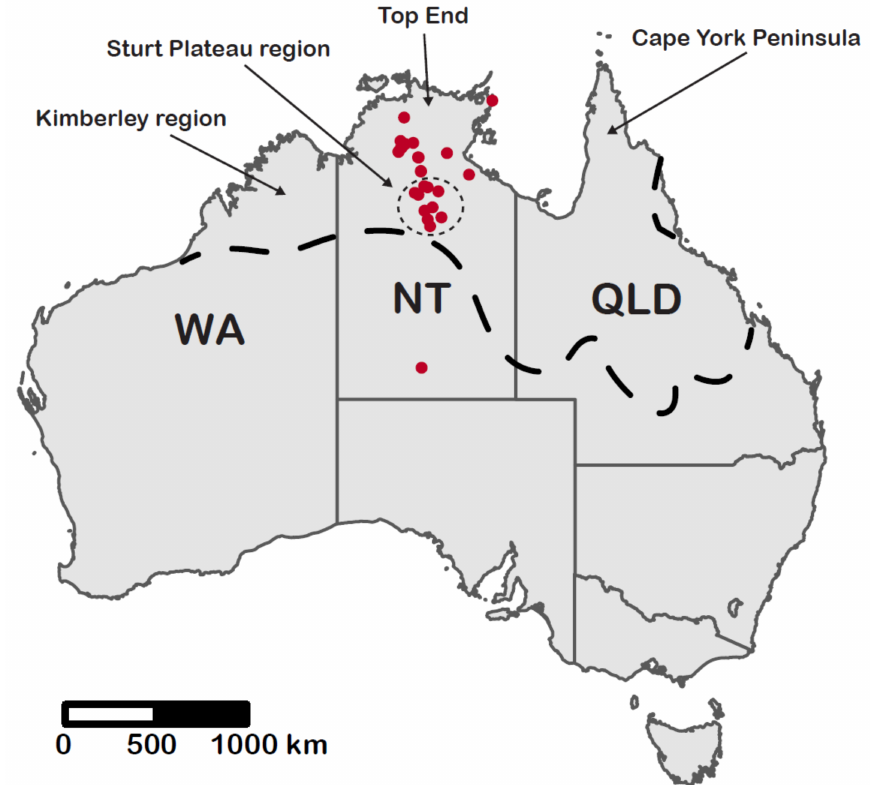
Figure 6. Map of Australia showing collection localities (red dots) for sequenced specimens of the Tetramorium spininode group. Many localities represent multiple sites. The four major biogeographic regions in northern Australia are indicated. The dashed line represents the approximate southern boundary of the monsoonal zone, where rainfall is very heavily concentrated in a summer wet season. Total annual rainfall ranges from about 2000 mm on the Tiwi Islands in the Top End to 500 mm on the southern boundary with the central arid